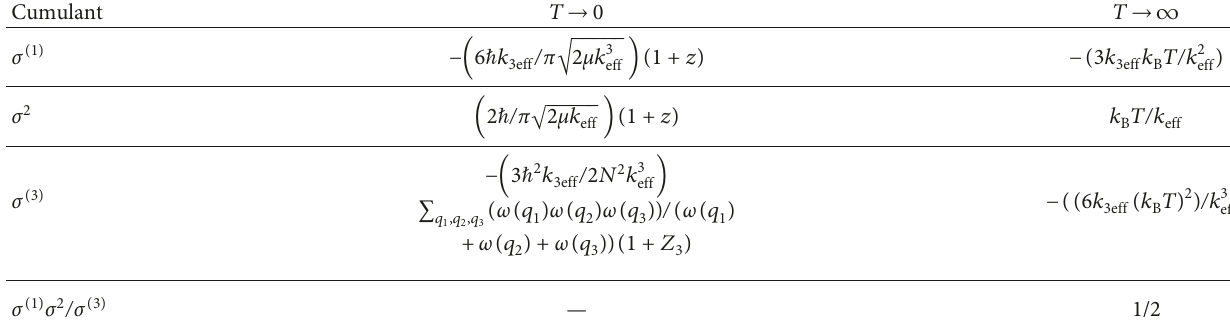
Table 1: Expressions of cumulants in LT ( T → 0) and HT ( T →∞ ) limits.